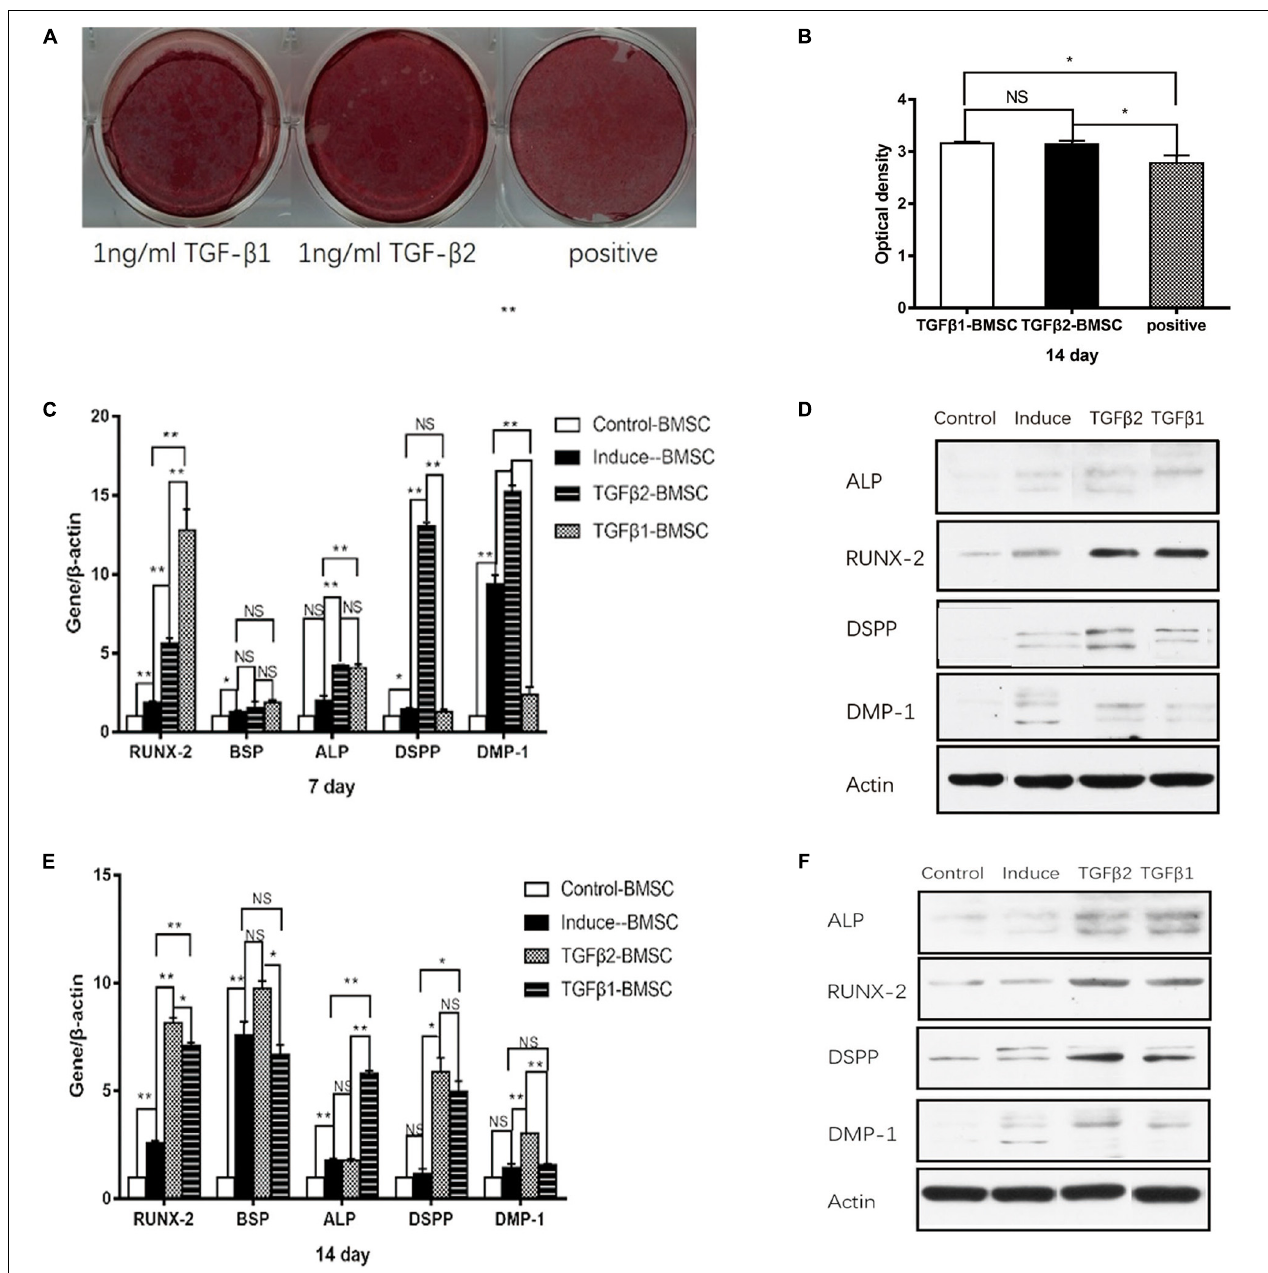
FIGURE 5 | The effects of rhTGF β 1 and rhTGF β 2 on the osteo/odontogenic differentiation of BMSCs. (A) After 2 weeks of culturing in different media, calcium mineral deposition was detected by alizarin red staining. (B) Quantitative measurement of alizarin red staining. Increased mineralized nodule was observed in the presence of 1 ng/ml rhTGF β 1 and 1 ng/ml rhTGF β 2 compared with OM at 14 days, with no significant difference between TGF β 1 and TGF β 2 groups. All data are presented as the mean ± SD (* p < 0.05; NS, no significance). Each experiment was repeated three times. (C,E) Real-time RT-PCR showing mRNA level of RUNX2, ALP, BSP, DSPP, and DMP1 of BMSCs after culturing in different medium at 7 days ( Figure 4C ) and 14 days ( Figure 4E ). All data are presented as the mean ± SD (* p < 0.05; ** p < 0.01; NS, no significance). Each experiment was repeated three times. (D,F) Western blotting analysis of expression of RUNX2, ALP, DSPP,